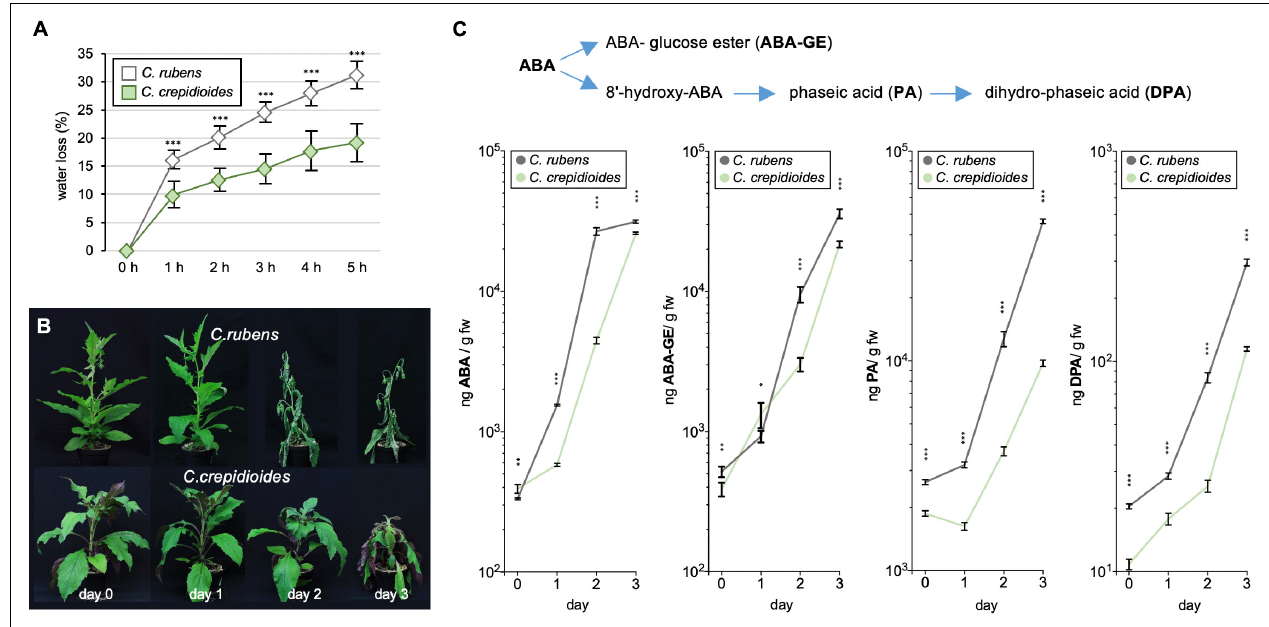
FIGURE 5 | Crassocephalum crepidioides shows reduced leaf water loss and delayed accumulation of ABA and its catabolites as compared to C. rubens . (A) Detached leaf water loss assays with leaves of 4-week-old C. rubens Mali and 5-week-old C. crepidioides Ile-Ife plants, grown in 16 h 80 µ mol m − 2 s − 1 white light/8-h dark cycles at a temperature of 25 ◦ C; n = 10. (B,C) The ABA measurements in drought-stressed plants. (B) Seven-week-old C. rubens Mali and 8-week-old C. crepidioides Ile-Ife plants, grown as in A, were subjected to progressive drought by withholding water for 3 days. Photos of representative plants are shown. (C) Levels of ABA, ABA-GE, PA, and DPA were then measured in these plants with LC-MS/MS; n = 4–5. In all graphs, the data show the mean ± SD; the asterisks indicate significant differences between genotypes by Student’s t -test ( ∗ p ≤ 0.05; ∗∗ p ≤ 0.01; ∗∗∗ p ≤ 0.001).